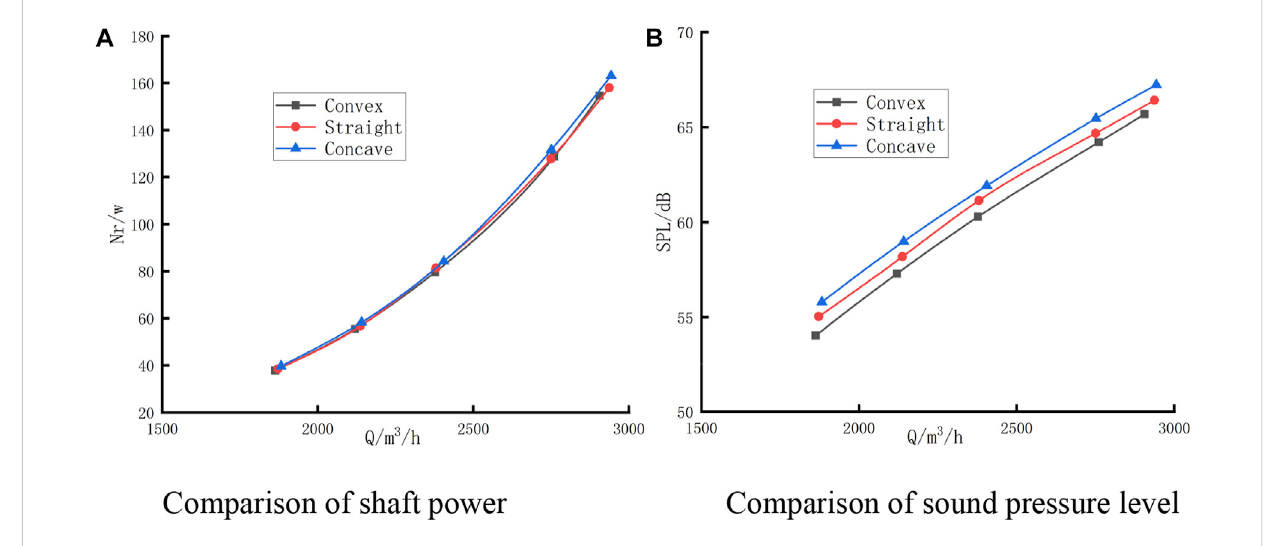
FIGURE 12 Variablerotationalspeedregulationcharacteristicsofthefanwithdifferentbladethicknesses: (A) comparisonofshaftpower; (B) comparisonofSPL.